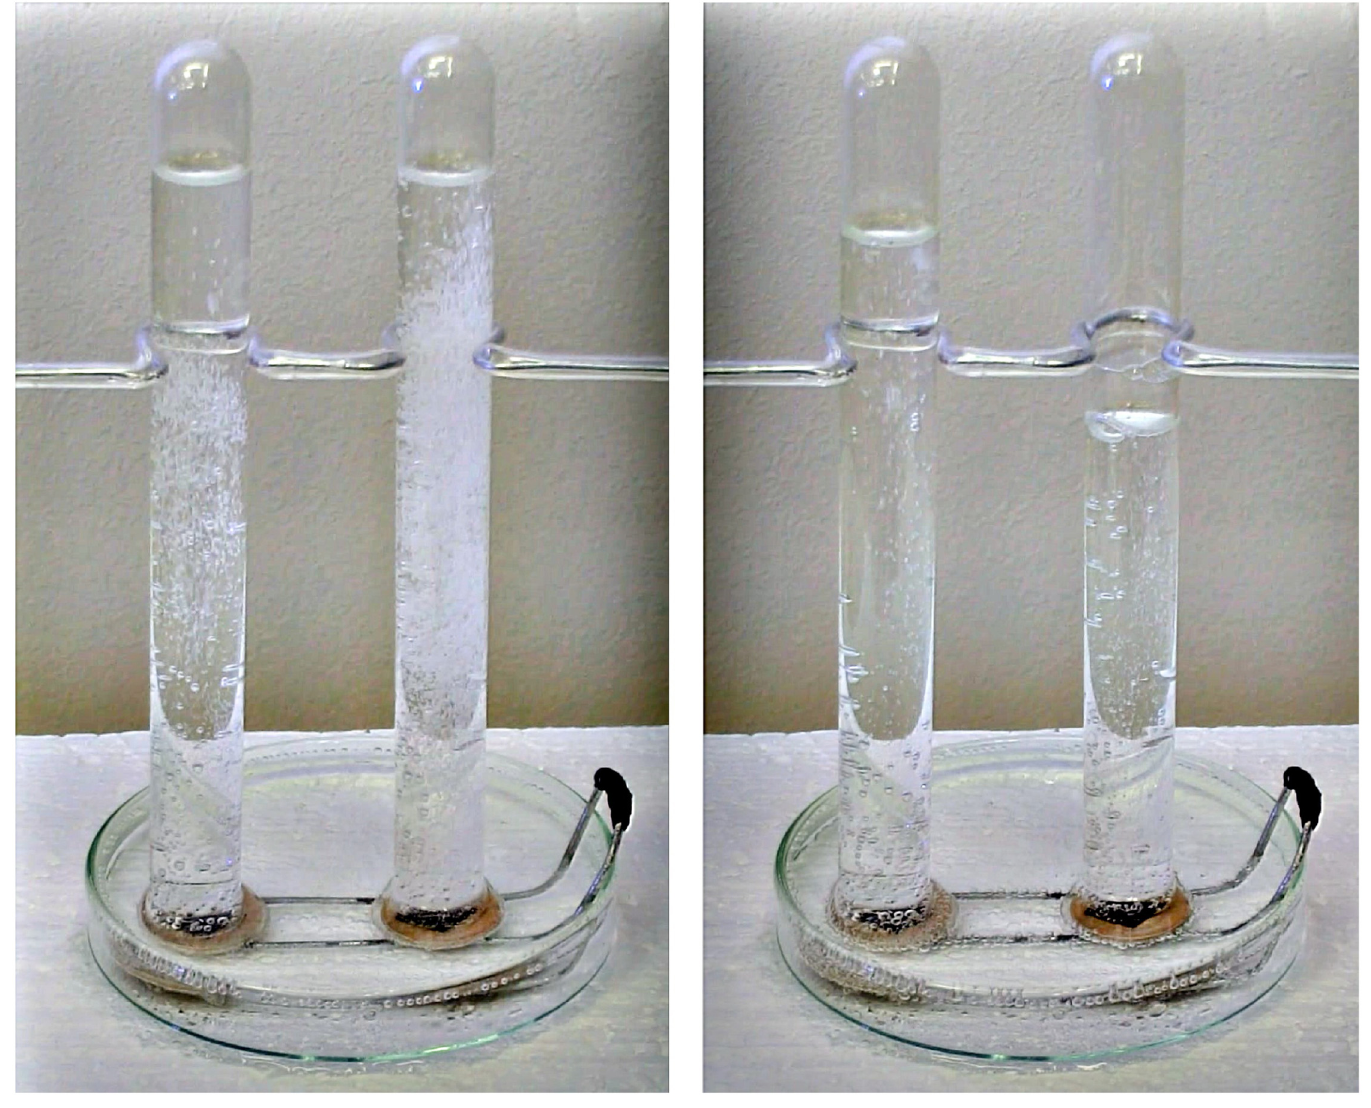
Fig 3. Effects of cellulose fibers (under the left test tube) and cellulose fibers wetted with surfactant (under the right test tube) on CO 2 bubbling in carbonated water. Left panel: Just after the two pieces of paper were inserted below the test tubes. Right panel: 48 s later. A movie of this experiment is available as supplementary material in the online version of the